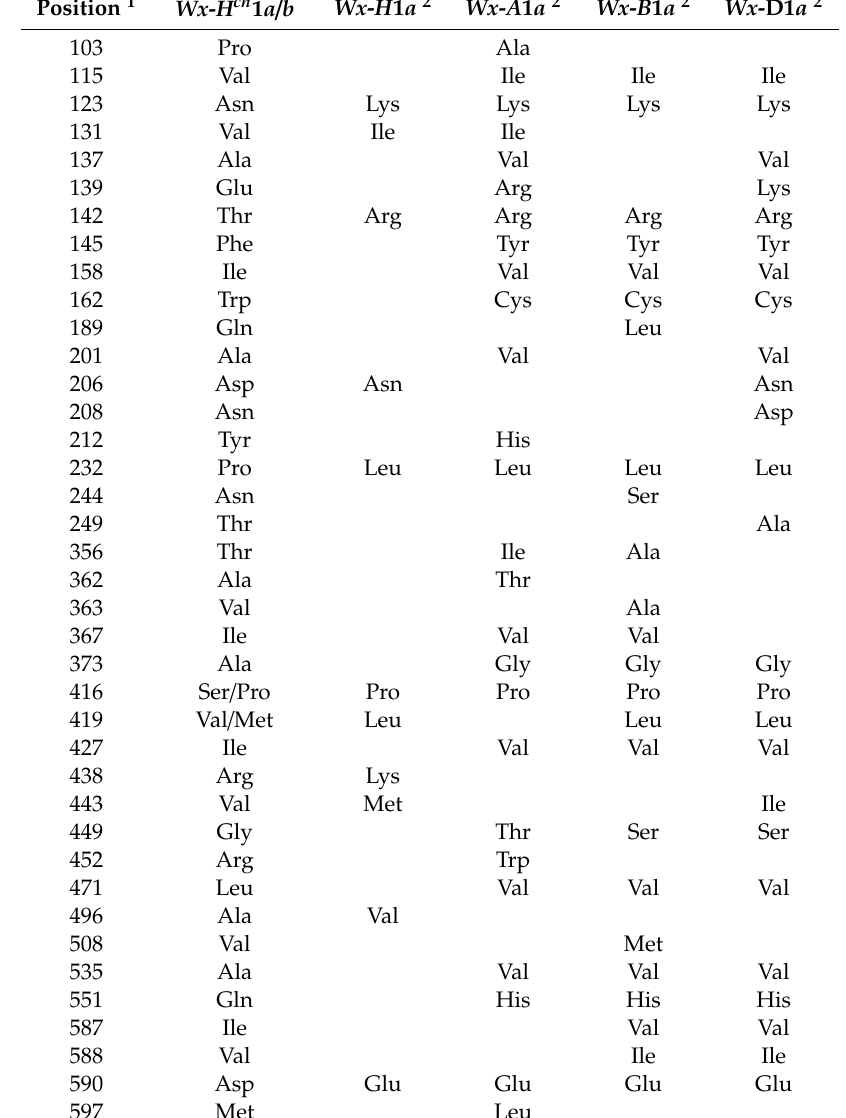
Table 2. Amino acid comparison of predicted mature protein among waxy protein variants